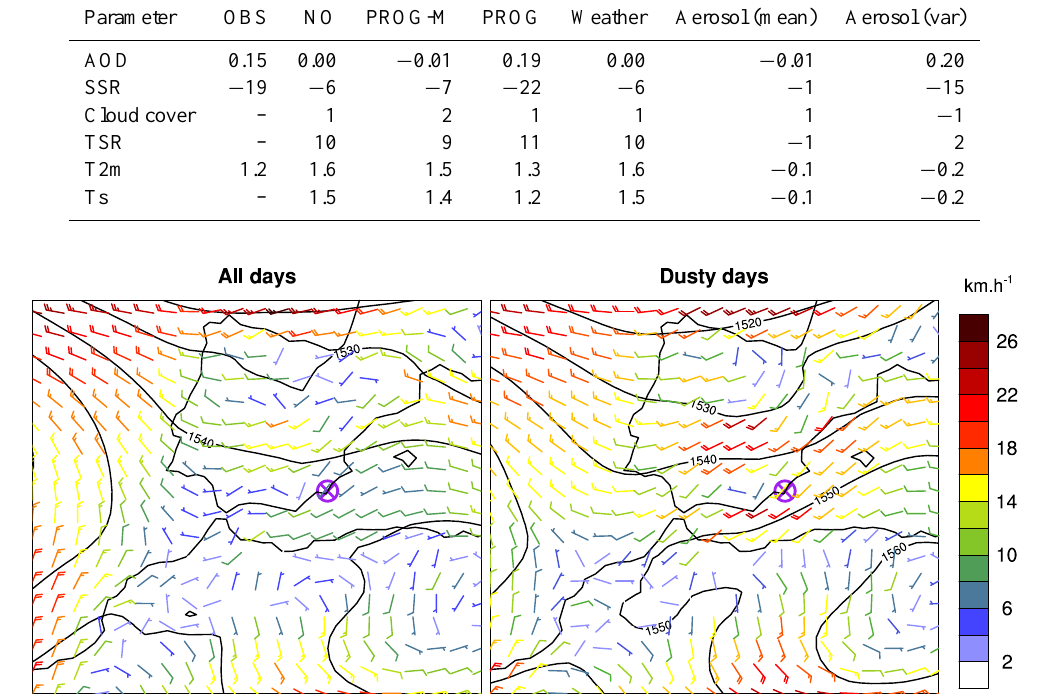
Fig. 11. Average wind (km/h, colored barbs) and geopotential (mgp, black lines) at 850 hPa for the set of all the days (left) and the dusty days (right) defined in Murcia (purple cross).